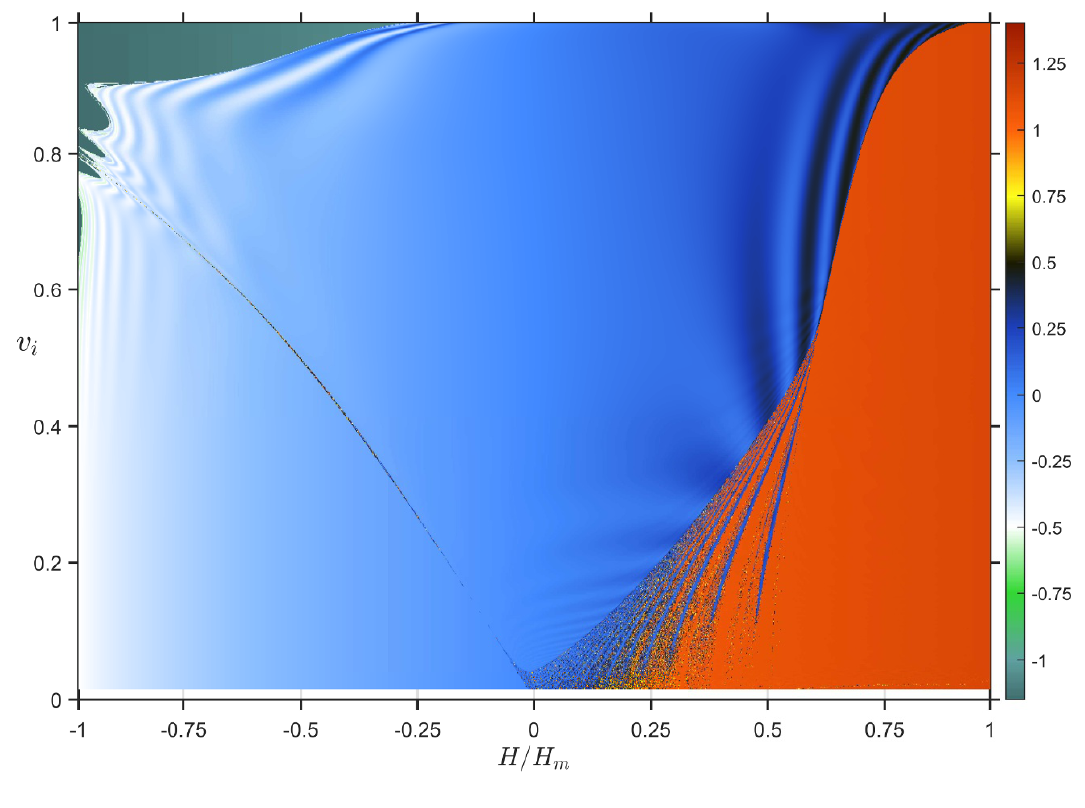
Figure 11 . Φ 2+ ( x ) antikink scattering with φ 1 ( the scalar field φ (0 , t f ), with t f =